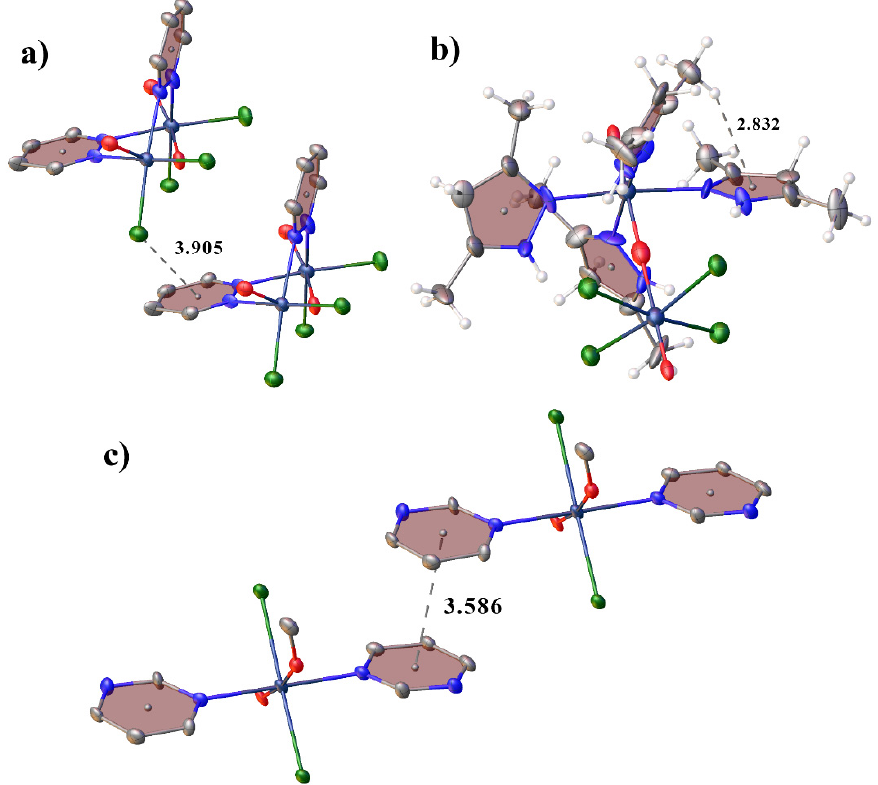
Figure 3. View showing halogen- π in 1 ( a ), CH- π in 2 ( b ) and π -stacking interactions in 3 ( c ). H-atoms are omitted for clarity in ( a ) and ( b ).